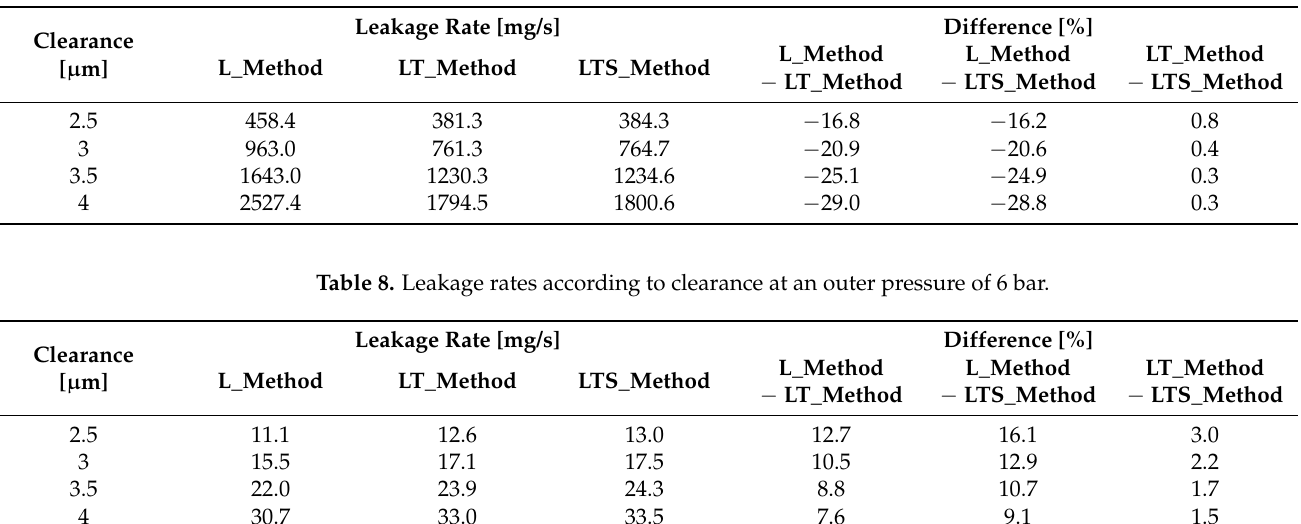
Table 7. Leakage rates according to clearance at an outer pressure of 60 bar.